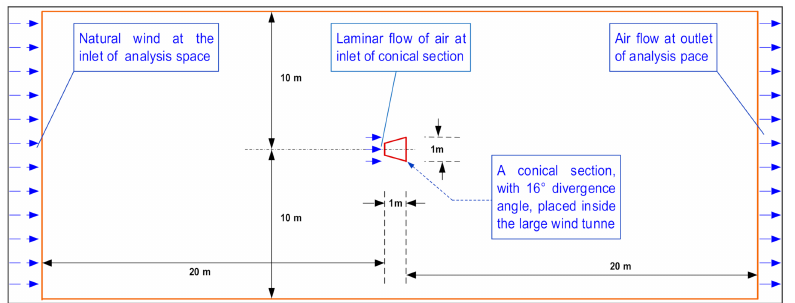
Figure 5. The physical domain considered for the simulation.